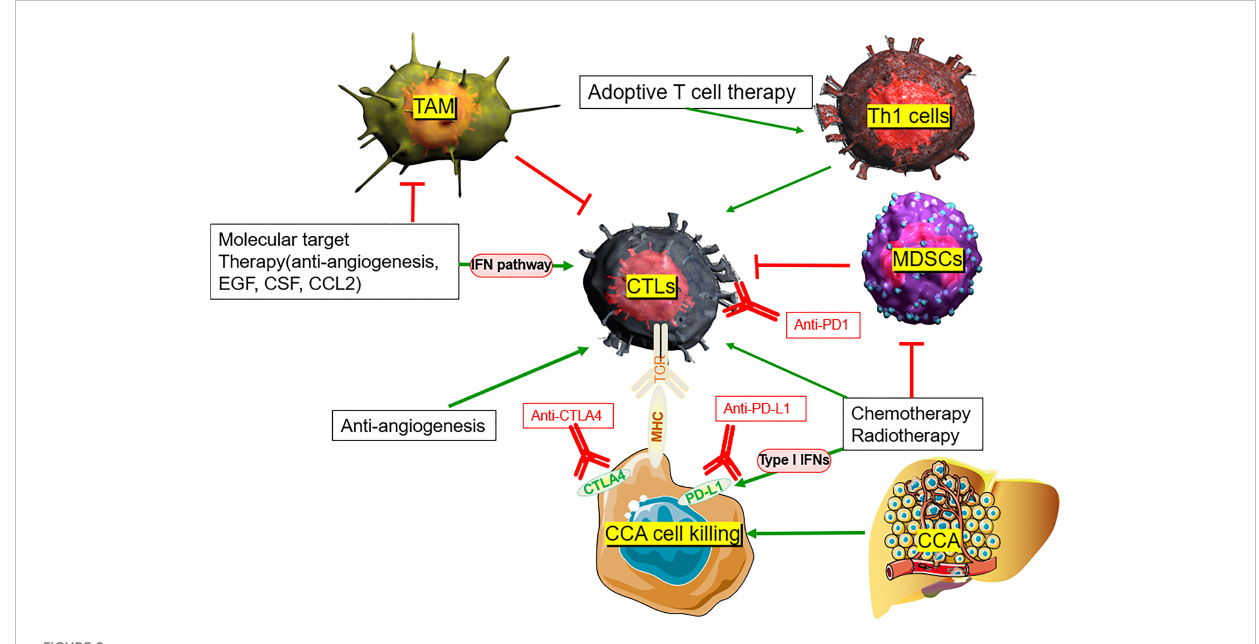
FIGURE 2 TME rationale of combination of ICB with other potential therapeutic strategies in